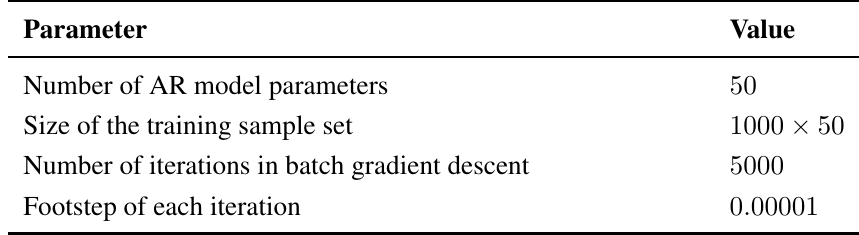
Table 1. Parameters used in constructing the AR model.